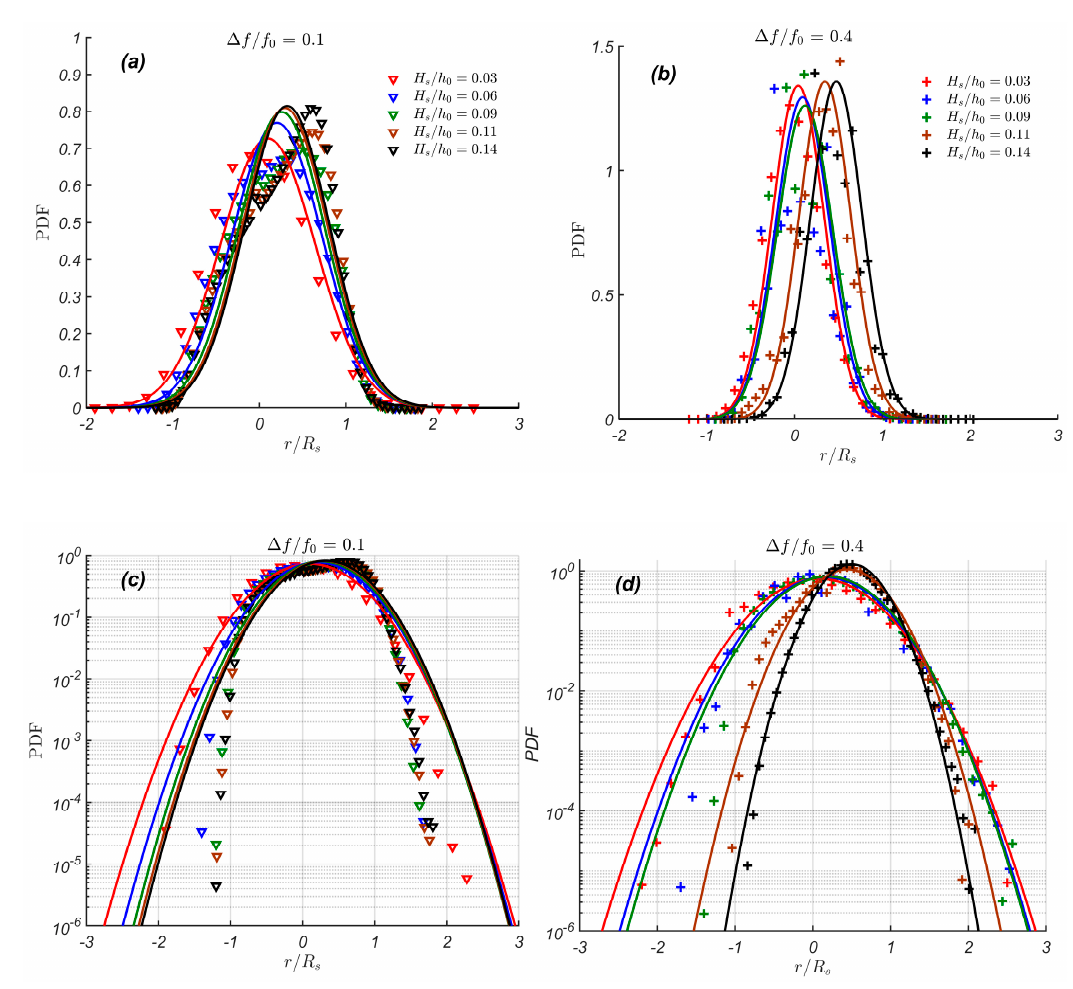
Figure 5. Probability density functions of runup oscillations, normalized by a significant runup height, R s , for di ff erent nonlinearities for narrow-banded ( a ) and ( c ), and wide-banded ( b ) and ( d ) waves in linear (top) and logarithmic (bottom) scales. Solid lines correspond to Gaussian distributions, fitted to the corresponding datasets, using the matching